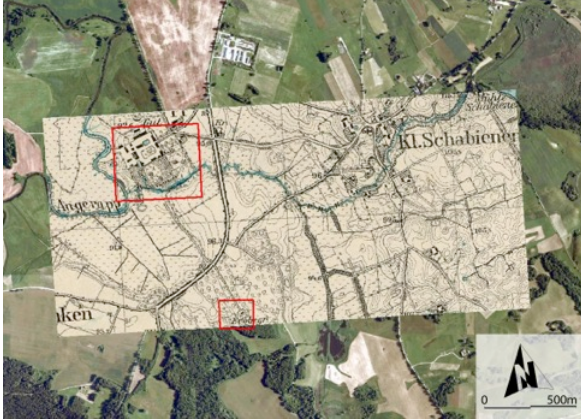
Figure 2. Rapa – a map sheet of Eastern Prussia (1938) over the aerial orthophoto (2012; GUGiK). The Pyramid was constructed about 1.0 km from the Angerapp (Rapa) Manor- Garden complex (red frame). A line of sight connecting the palace with the pyramid ran through the park situated along the southern part of the Rapa Manor (M. Szostak) It originally served as an icehouse, that is a place where ice could be stored (Łapo 2016b). More than likely, its archetype was the "ice pyramid" from Potsdam (Fig. 3) built in 1791-1792 as part of the royal New Garden (Neuen Garten).